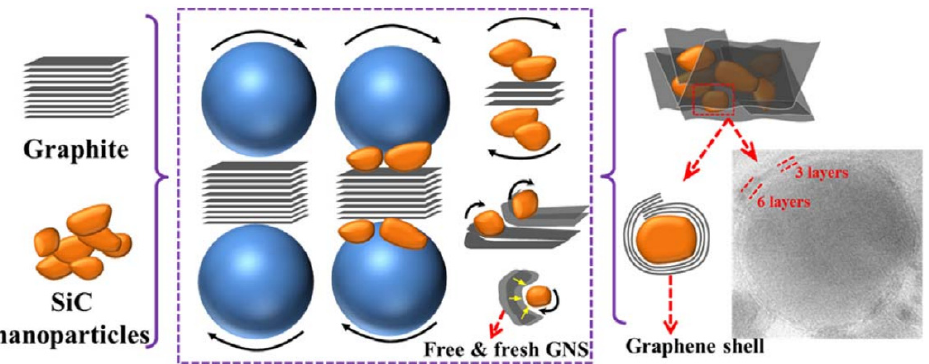
Figure 4. Schematic drawing showing exfoliation of graphite/GNSs and encapsulation of SiC nanoparticles with GNSs [62]. Reprinted with permission from ref. [62]. Copyright 2018 Elsevier Ltd. and Techna Group S.r.l.